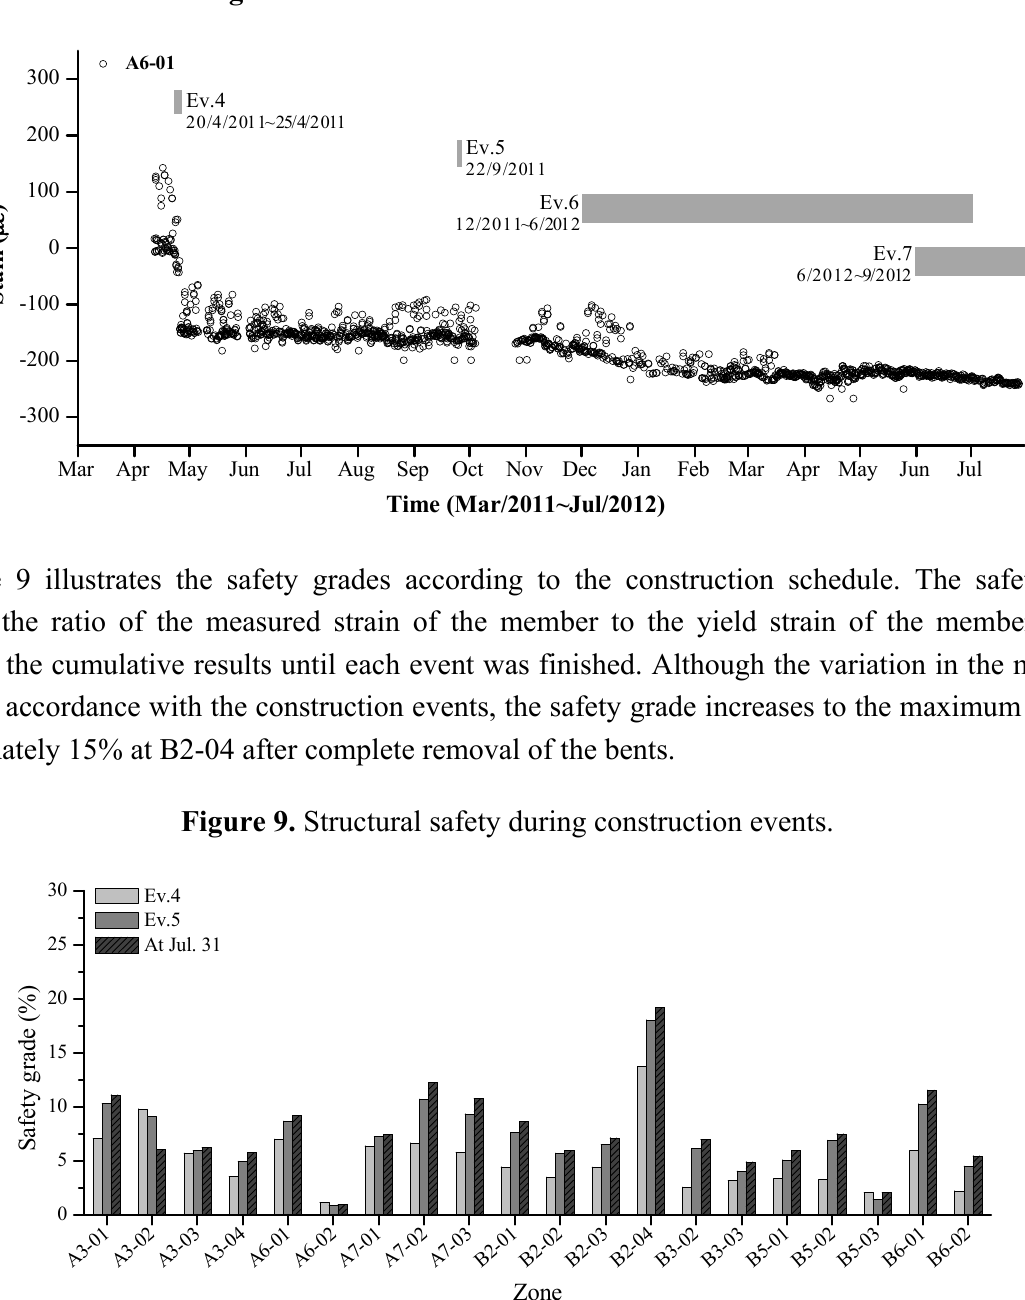
Figure 8. Construction events and strain of A6-01.